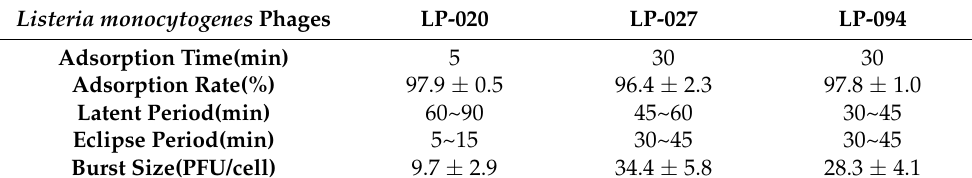
Figure 4. One-step growth curve of Listeria monocytogenes F2365 treated with ( A ) LP-20, ( B ) LP-0-27, or ( C ) LP-094 at a MOI = 0.1 at 25 °C. Filled triangles represent the phage titer in chloroform treated samples and unfilled triangles represent the phage titer in untreated samples. Data are mean values of three biological replicates and error bars represent standard error.